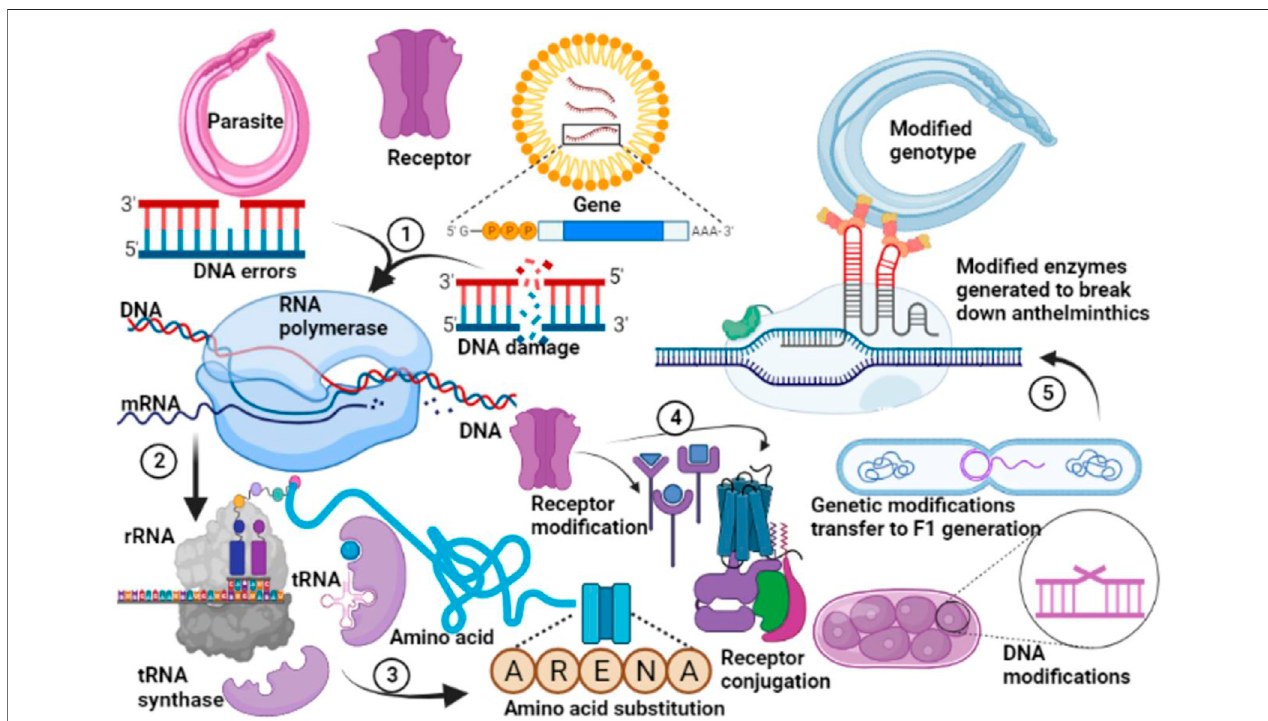
FIGURE 8 | General mechanism of resistance to anthelmintic drugs. Genetic modi fi cations in the parasite occur following decades of application of allopathic anthelmintics. DNA replication errors subsequently promote evolutionary changes in the gene of the parasites to form stable DNA (1). This undergoes transcription (2), and translation (3) with substitution of primary amino acids associated with susceptibility with those which favour resistances against anthelmintics. Subsequent protein modi fi cations (4) favour expression of receptors which inhibit or reduce anthelmintic binding thus protecting the parasite from anthelmintic action. These genetic modi fi cations are transferred to the offspring, favouring selective evolutionary changes which produce metabolic enzymes which degrade anthelmintics (5). A modi fi ed genotype is subsequently created which produces subsequent offsprings which are completely resistant to anthelmintics.